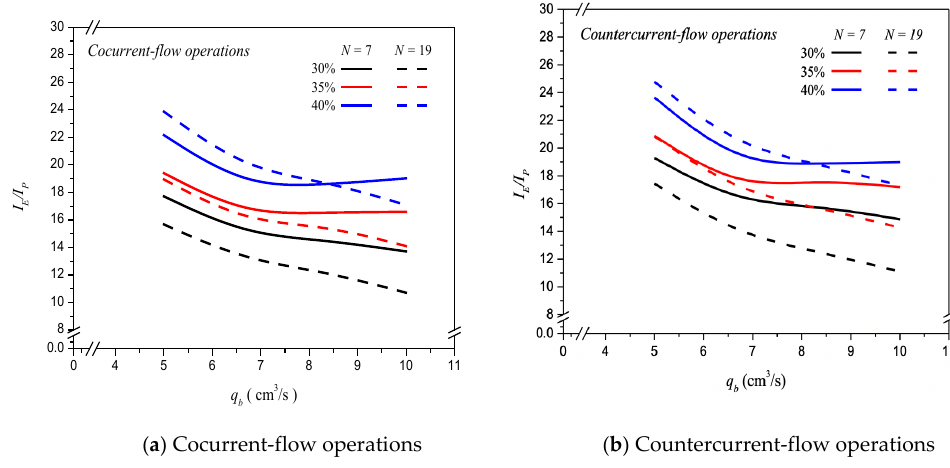
Figure 11. Effects of MEA flow rate, various fiber cells, and feed CO 2 concentration on I E / I P